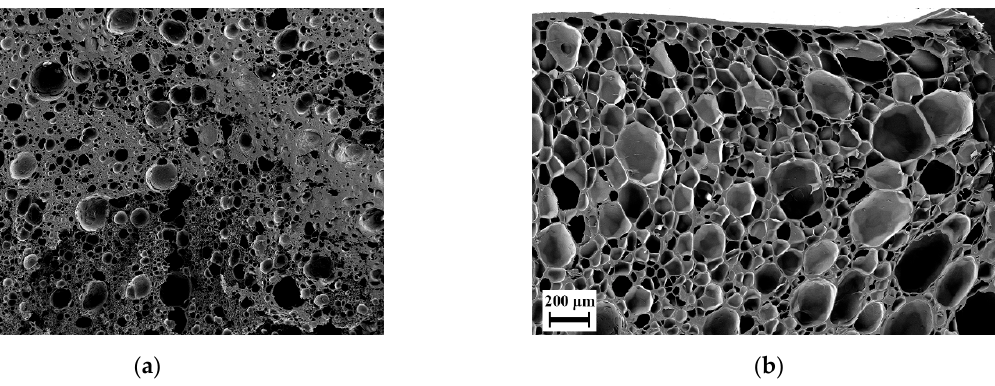
Figure 7. Scanning electron micrographs of foams of blend H-32 manufactured at loading time 48 h, pressure 100 bar, loading temperature 150 °C, foaming time 100 s and foaming temperature 230 °C: ( a ) Using only CO 2 as foaming agent; ( b ) Using CO 2 and H 2 O as foaming agents.